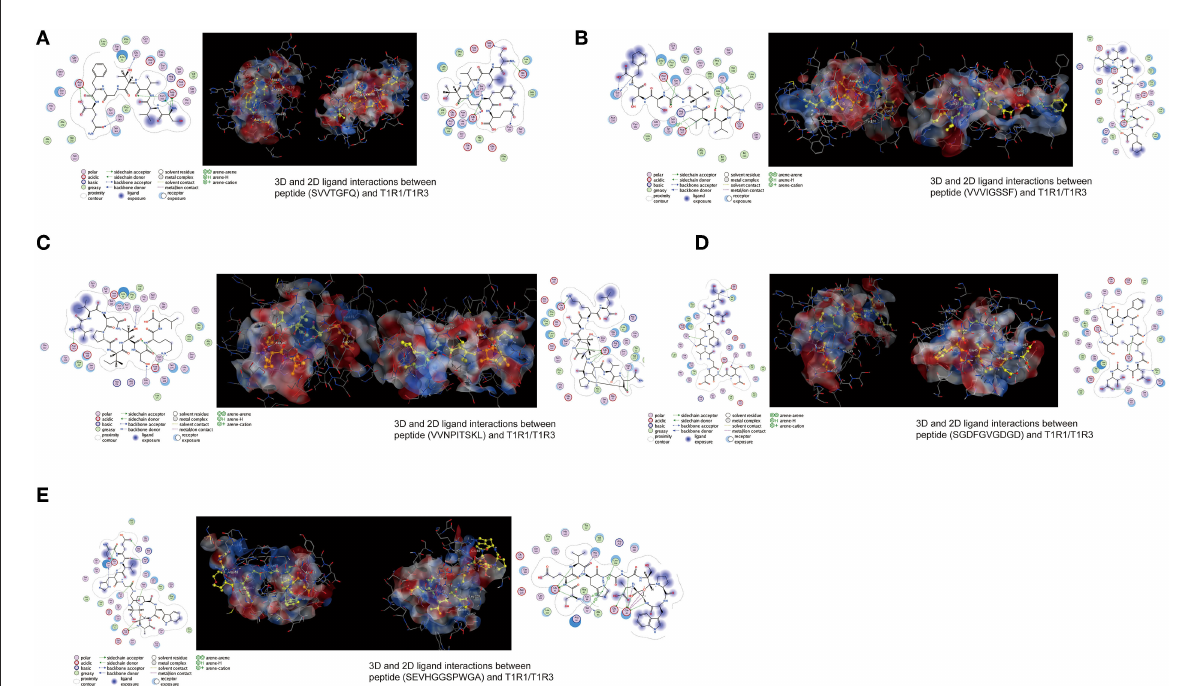
FIGURE7 (A–E) 3D and 2D ligand interactions between peptides and T1R1/T1R3 amino acids. The left figure shows the 2D diagram of peptide binding to T1R1, the middle figure shows the 3D graph of peptide docking to T1R1/T1R3, including the electrostatic model of the receptor cavity-binding domain, the yellow ball and stick model peptide, and the binding amino acid sites, and the right figure shows the 2D diagram of peptide binding to T1R3.